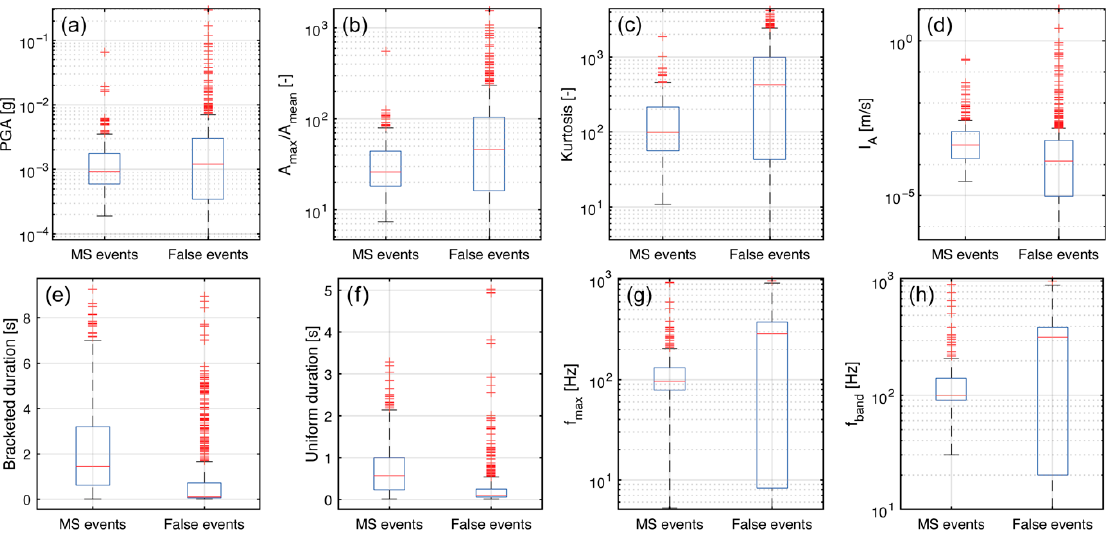
Figure 8. Synthesis of the statistical comparison between the two manually identified classes of detected events. For each class, the extension of the blue boxes represents the interquartile range (IQR, defined as the difference between the upper (Q3) and lower (Q1) quartiles), red lines are median values, black whiskers extend to extreme values, and red crosses are the not-considered outliers. The parameters considered for this analysis are PGA ( a ), normalized amplitude ( b ), kurtosis ( c ), Arias intensity ( d ), bracketed ( e ) and uniform duration ( f ), peak frequency ( g ), and most energized frequency band ( h ).